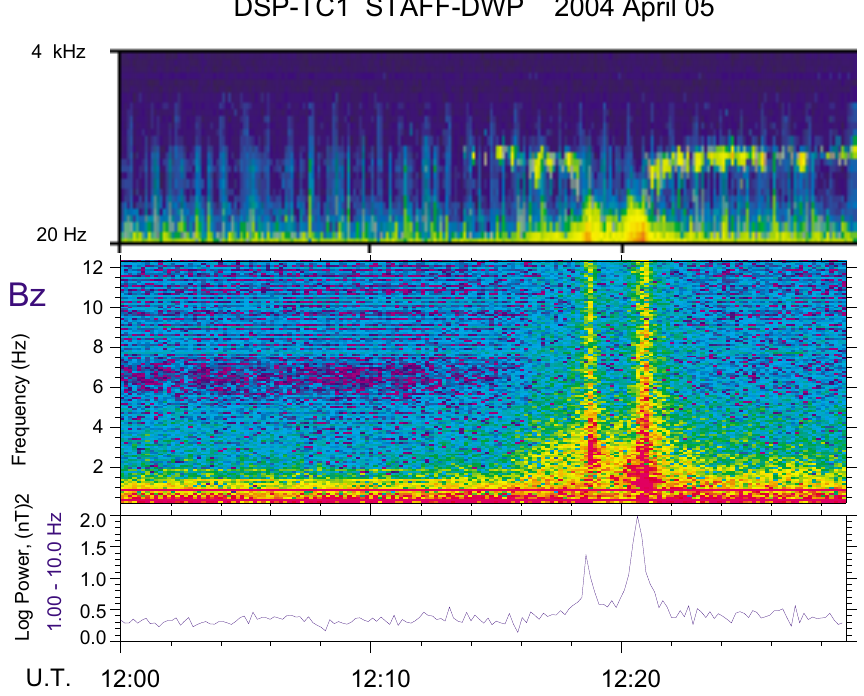
Fig. 7. Thirty minutes of STAFF data on 5 April 2004 when DSP was in the magnetosheath, at 09:30 LT, and went for a short excursion into the solar wind around 12:20 UT. From top to bottom are the dynamic spectra of total power from the spectrum analyzer (20Hz–4kHz), the dynamic spectra for the B z component of the waveform data in the 0.5–12Hz frequency range and the integrated power of the same component in the frequency range 1–10Hz. The turbulence associated with the shock crossings is seen by both parts of the experiment, up to about 70Hz, whereas on each side of the shock crossings, narrow band lion roars are clearly visible in the